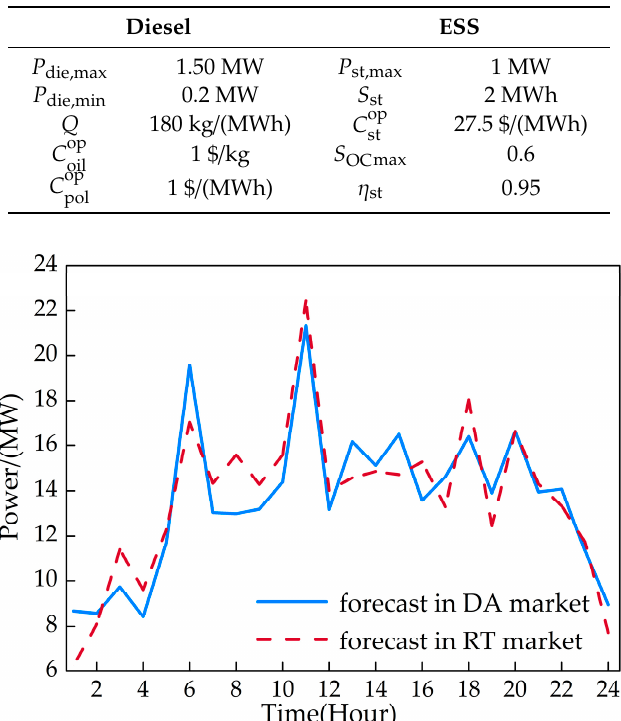
Figure 7. DA market clearing price. The scheduling for the VPP in DA and RT market bidding were performed, and the outcome of the different VPP participants is given in Figure 8.